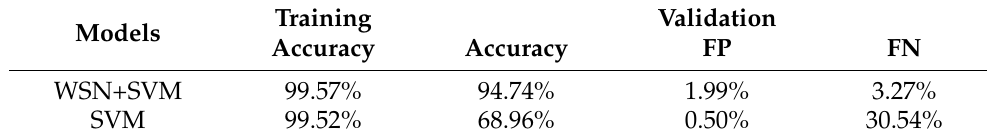
Table 4. Accuracy and false rates of classifying vertical traces with or without WSN (Type-II dataset).